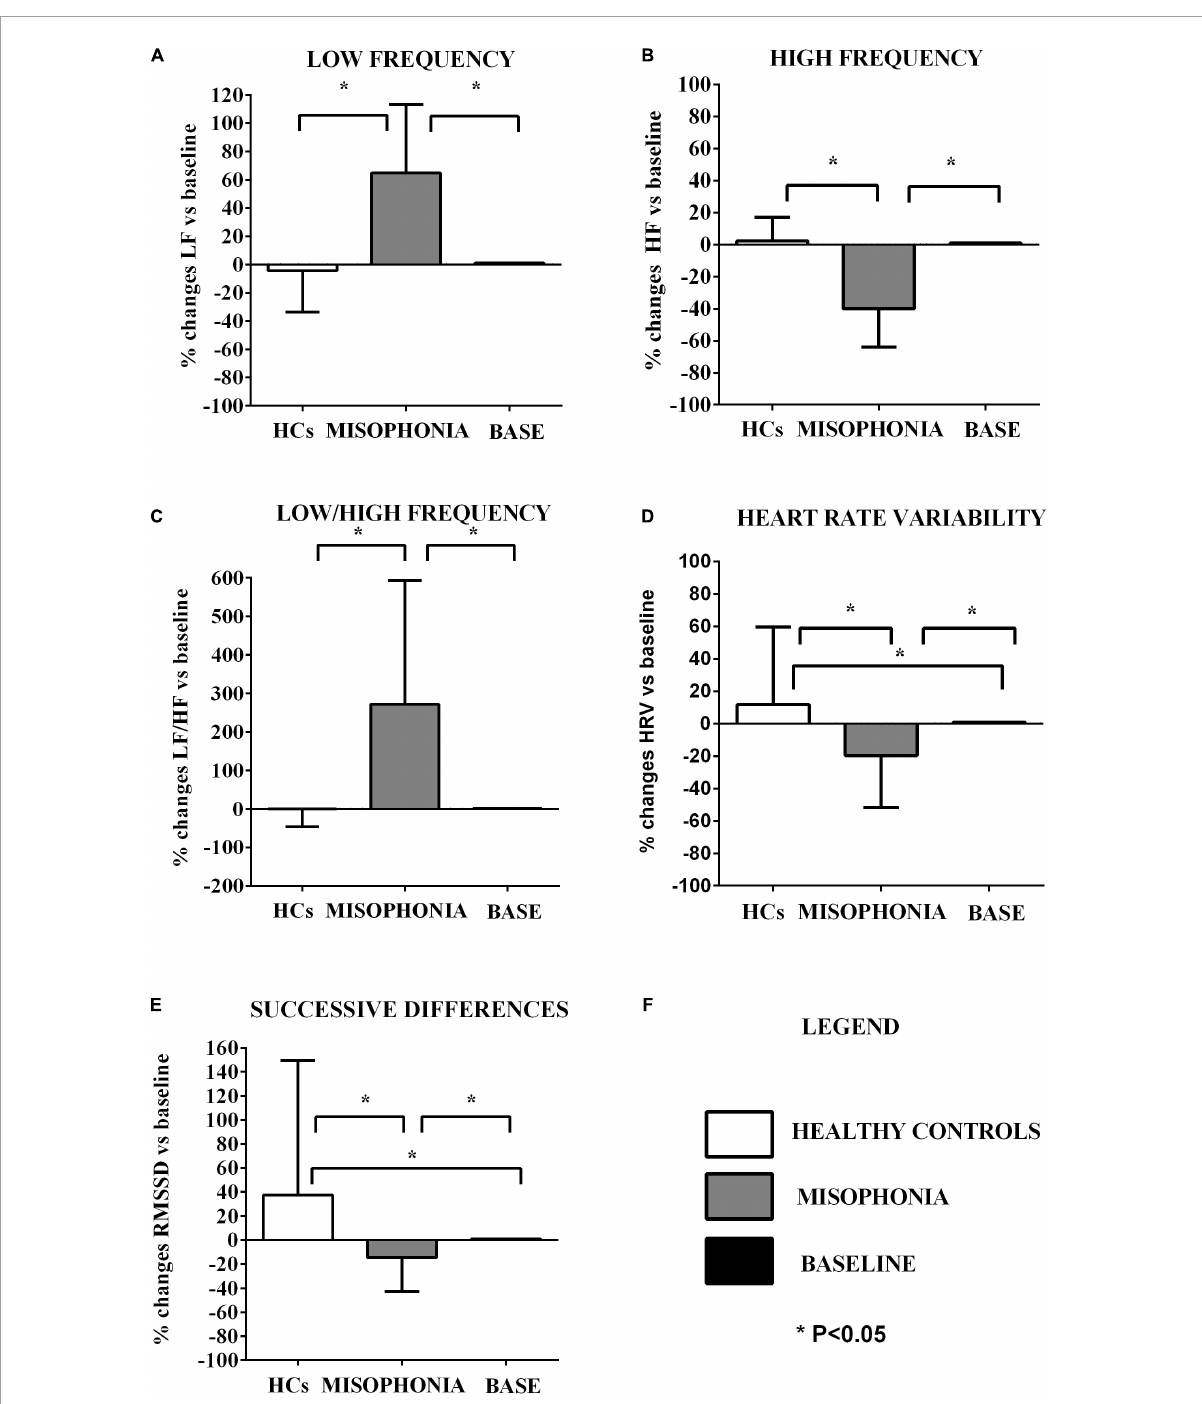
FIGURE2 Effects of the trigger sounds protocol on HRV variables in participants with misophonia and participants without misophonia [healthy controls (HCs)] vs. specific baseline (set as 1). The results show increased orthosympathetic variables (LF, LF/HF) in participants with misophonia and increased parasympathetic variables (HRV triangular index, RMSSD) in participants without misophonia in comparison with values registered at baseline. It is also to note that the parasympathetic variables (HF, HRV, and RMSSD) were decreased in participants without misophonia RMS in comparison with values registered at baseline LF, low frequency (A) ; HF, high frequency (B) ; LF/HF (C) , low frequency/high frequency ratio; HRV (D) , heart rate variability triangular index; RMSSD (E) , the root mean square of successive differences between normal heart beats. The results are the mean ± SE. The parenthesis indicate significance between groups, as specified in panel (F) . In panel (F) , the explanation for various groups’ representation is reported. The statistical analysis between M and HCs was performed through the Mann–Whitney test, whereas the statistical analysis between M/HCs and baseline was performed through the Wilcoxon